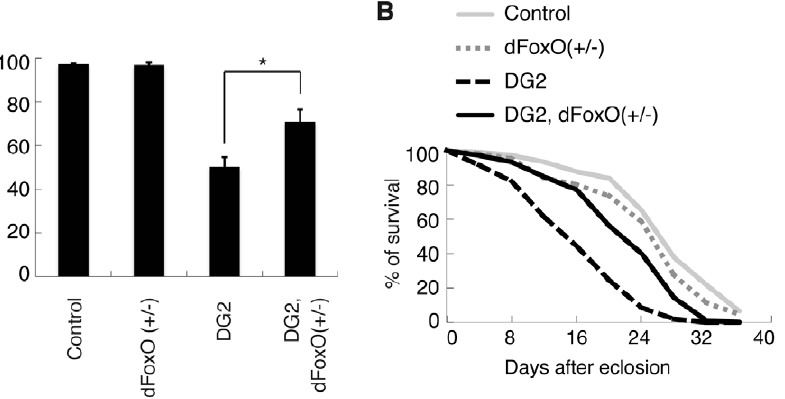
Figure 7. Reduction of endogenous dFoxO activity suppresses DG2-mediated toxicity. ( A ) The climbing activity was measured as in Figure 6C. The values represent means 6 SE for 20 trials in three independent experiments (*, p , 0.05). ( B ) Survival assays of female adults ( n =105– 106) were performed as in Figure 6E. DG2 vs. DG2, dFoxO ( + / 2 ), p , 0.01; DG2, dFoxO ( + / 2 ) vs. Control, p , 0.01. The genotypes are: elav-GS/ + (Control), UAS-DG2 ; elav-GS (DG2), elav-GS/dFoxO 21 (dFoxO ( + / 2 )), UAS-DG2 ; elav-GS/dFoxO 21 (DG2, dFoxO ( + / 2